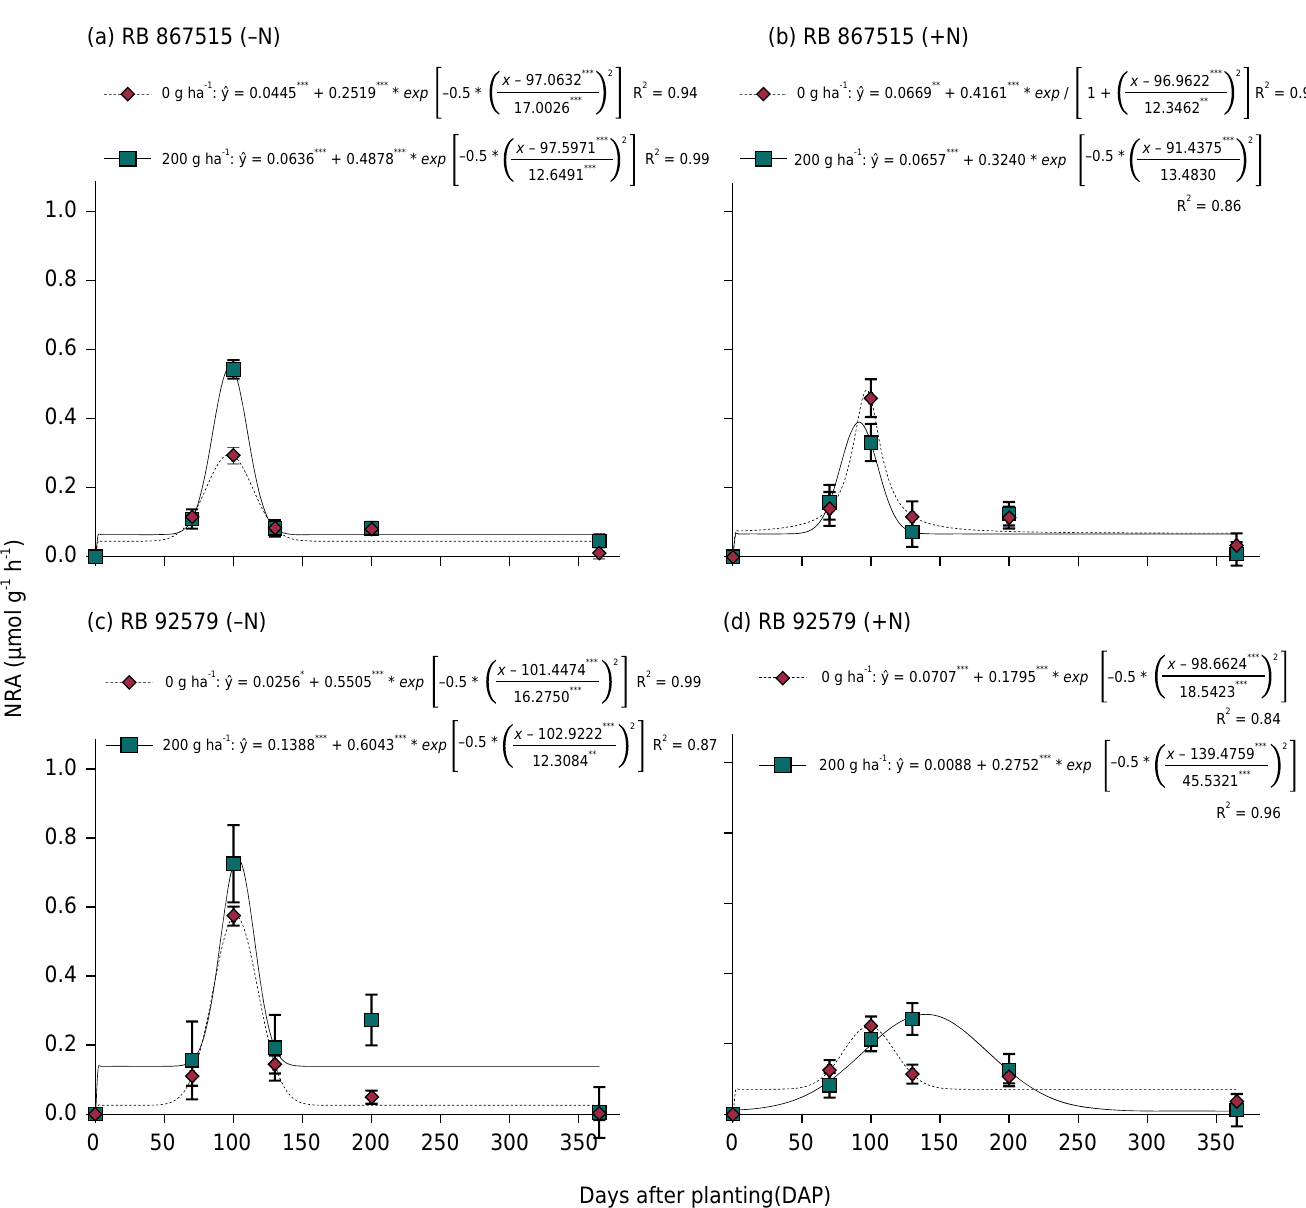
Figure 2. Nitrate reductase activity (NRA) in the roots of sugarcane - Mo and +Mo (200 g ha -1 of Mo) fertilization for the variety RB 867515, -N and +N (60 kg ha -1 of N) fertilization (a and b respectively), and for the variety RB 92579, -N and +N fertilization (c and d respectively) at 70, 100, 130, 200, and 365 days after planting